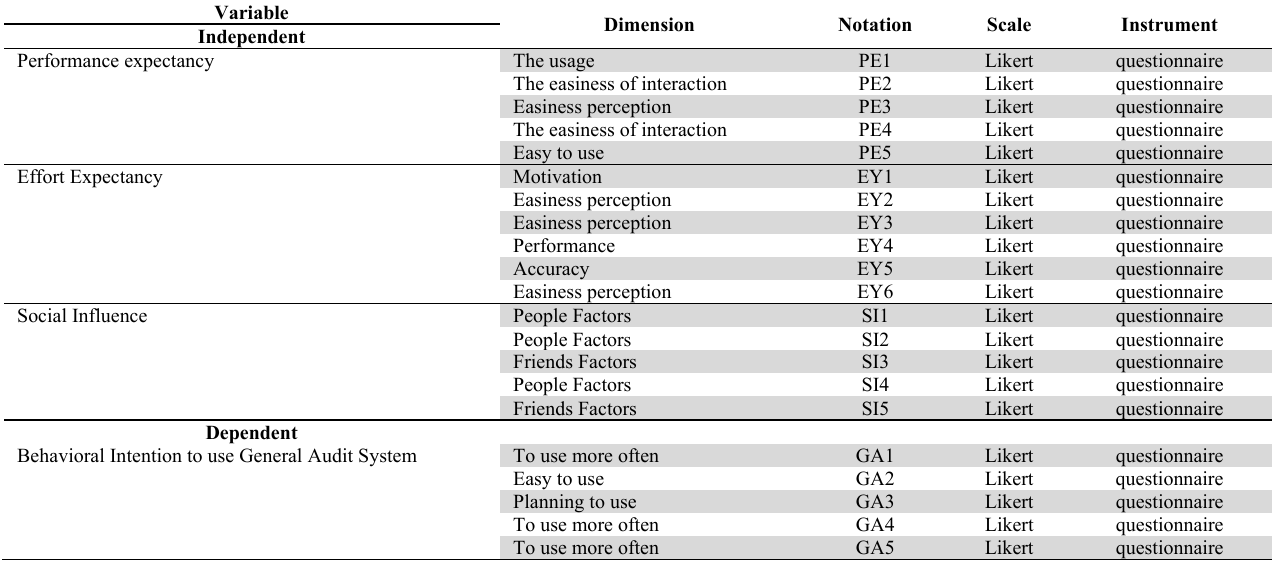
Operational Variables